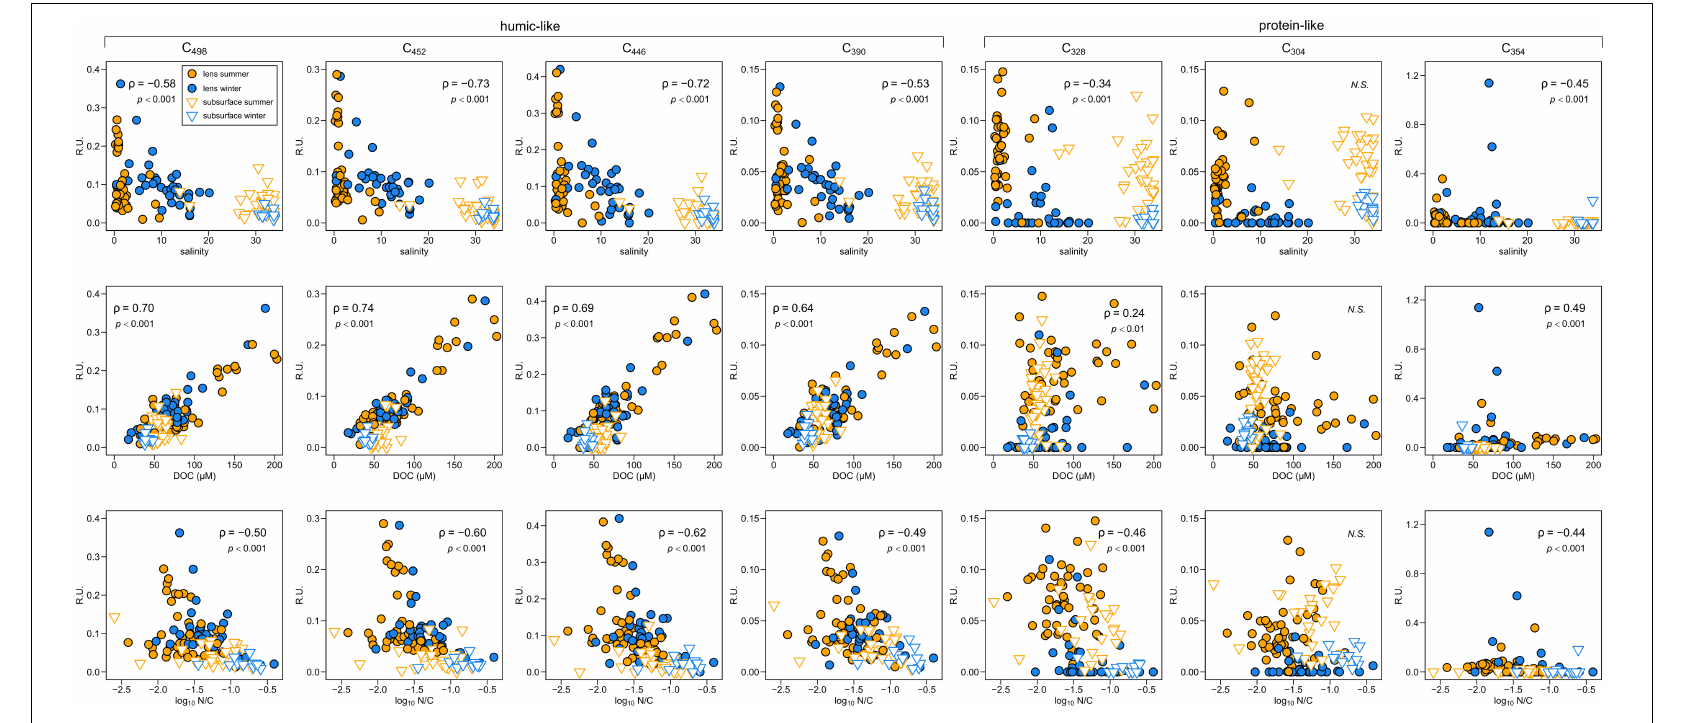
FIGURE 3 | Dissolved organic matter fluorescence intensity variations with respect to salinity (top row), DOC concentration (middle row) and molar N/C ratios (log scale, bottom row) in Baker-Martinez Fjord. Different y -axis scales (fluorescence intensity; Raman units) used for each PARAFAC component. Symbol shapes and colors indicate surface/subsurface samples and sampling season, respectively; key in upper left panel. Each sub-panel is annotated with non-parametric correlation coefficient (Spearman’s ρ ) and p -value or “ N.S. ” for non-significant ( p > 0.05)